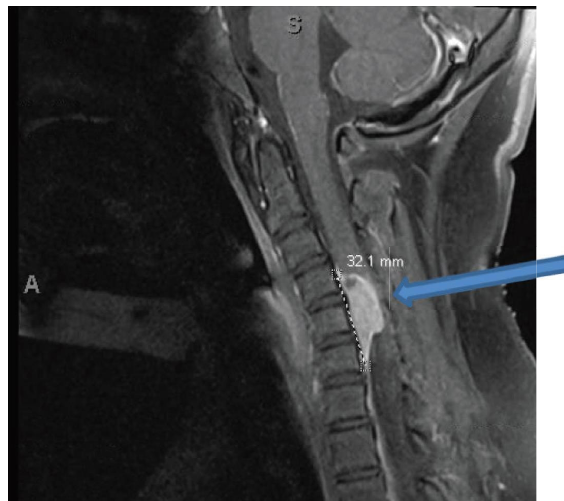
Figure 1: Sagittal T1-weighted preoperative MRI with contrast showing an anterior intradural extramedullary mass, measuring 1.6 × 0.9 × 2.8cm (blue arrow). Te mass is centered at C5 and spans from C4-6 with what appears to be a dural tail. Te mass shows signifcant compression of the spinal cord.